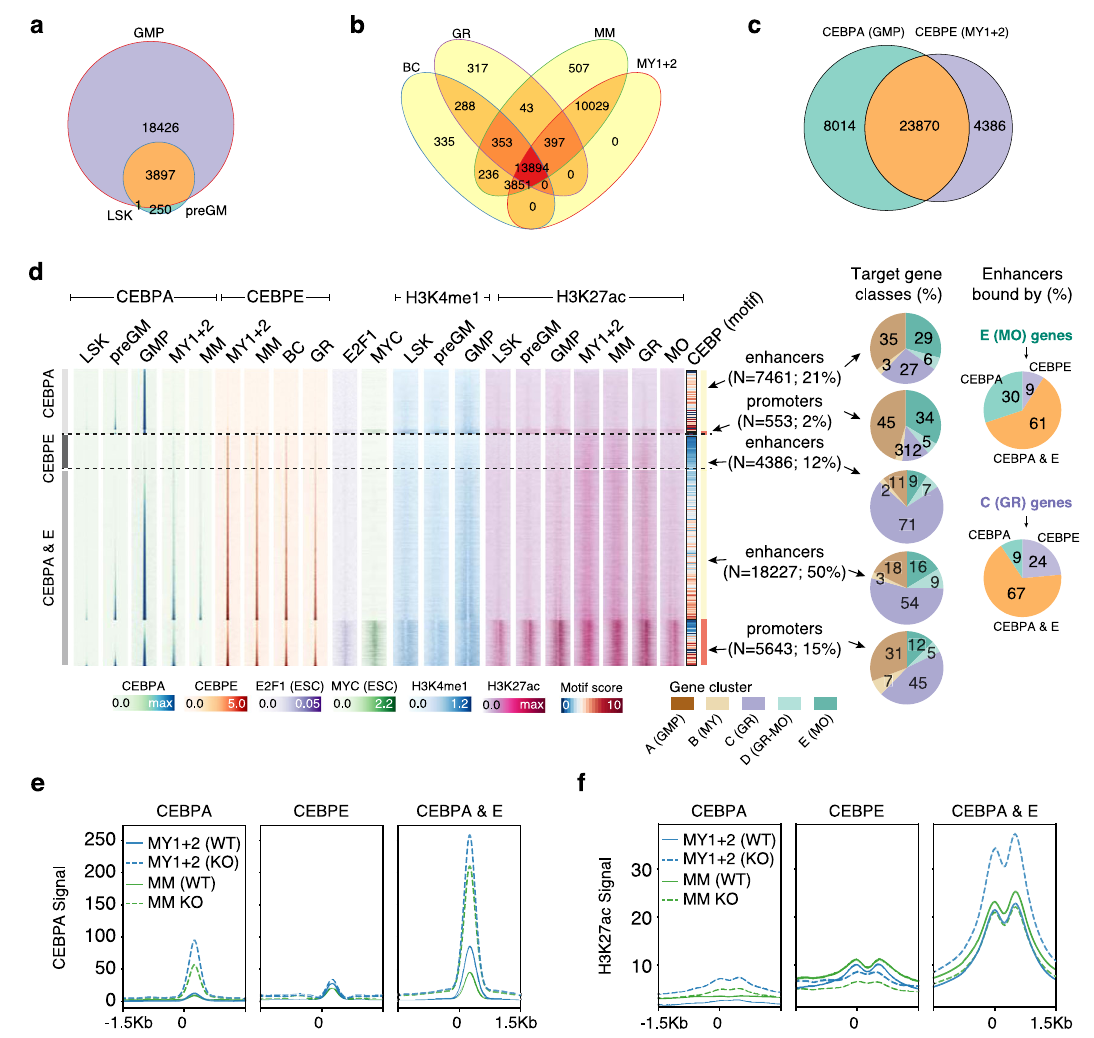
Fig. 6 CEBPA and CEBPE binding dynamics to cis-regulatory elements during early and late granulocytic differentiation. a Regions bound by CEBPA during early granulocytic differentiation in LSKs, preGMs, and GMPs demonstrate signi fi cant overlap and the most abundant binding of CEBPA in GMPs. b Regions bound by CEBPE in MY1s + MY2s, MMs, BCs, and GRs demonstrate signi fi cant overlap of CEBPE binding and the most abundant binding of CEBPE in MY1s + MY2s and MMs. c Regions bound by CEBPA in GMPs and by CEBPE in MY1s + MY2s demonstrate a high overlap of CEBPA and CEBPE binding during early late granulocytic differentiation. d Heatmap showing the levels of CEBPA, CEBPE, H3K4me1, and H3K27ac at promoters and enhancers (>1000 bp from TSS) for indicated BM populations, along with their target gene clusters. Shown alongside the CEBPE binding motif score for each region are the E2F1 and MYC binding af fi nities for the same regions in embryonic stem cells (ESC). Also shown are the H3K4me1 (priming marker) and H3K27ac (activation marker) levels at enhancers for indicated BM populations. e , f CEBPA binding ( e ) and H3K27ac modi fi cation ( f ) levels at regions bound by CEBPA and/or CEBPE (i.e., CEBPA & E, CEBPA, CEBPE) for the indicated populations. Source data are provided as a Source Data fi